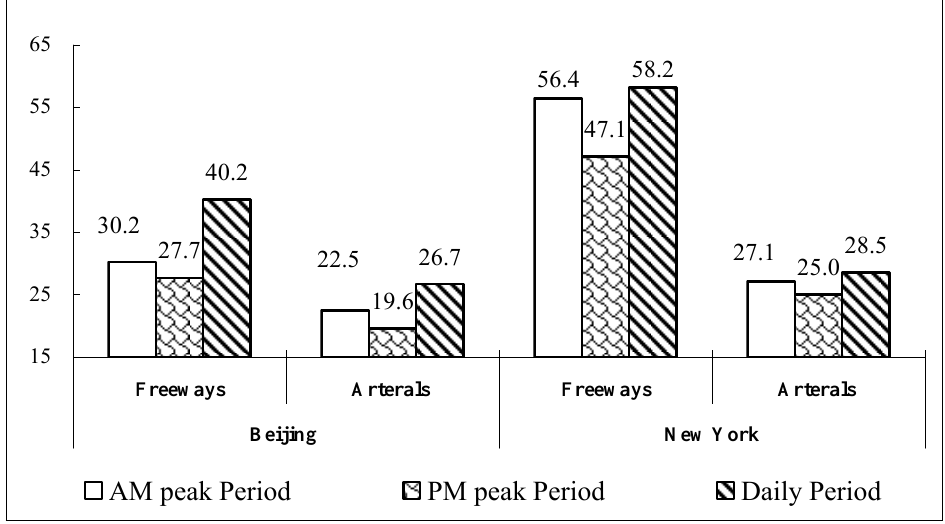
Fig. 5. Vehicle speed comparison in different grade road of Beijing, New York and London The m ain reason s lead ing to th is situ ation are alm ost same ones analyzed in last